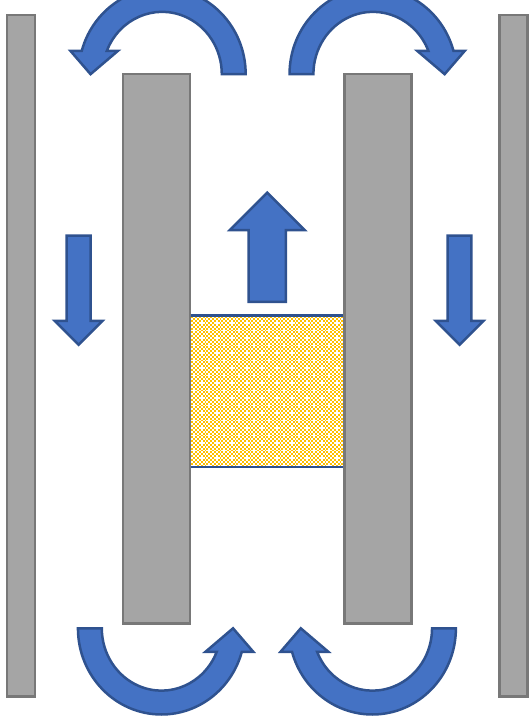
Figure 13. Sketch of the flow pattern through the reactor.